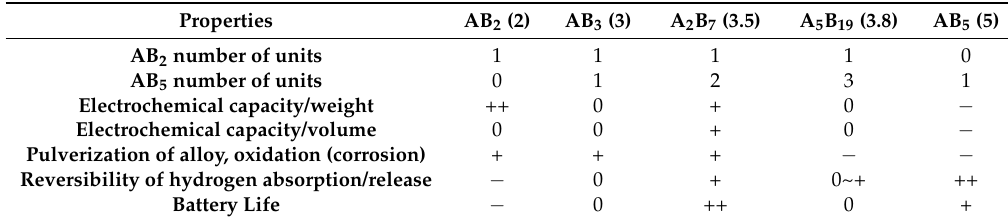
Table 1. The performance comparison of hydrogen-absorbing alloys with different chemistries [12]. The numbers in parentheses are the nominal B/A ratios. The symbols are ++ (superb), + (good), 0 (acceptable), and − (poor).